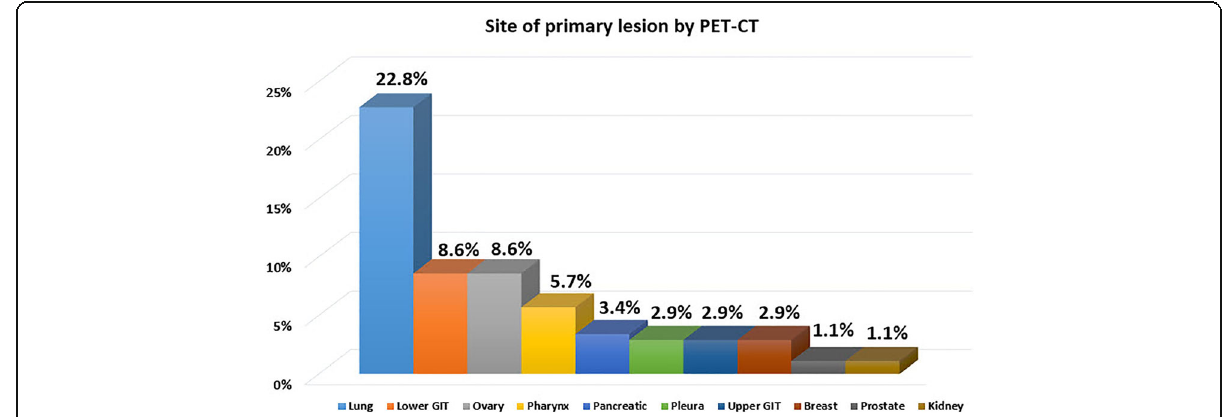
Fig. 1 3D bubble X - Y scatter chart shows the sites of primary tumors detected by PET-CT ( n = 105/175,